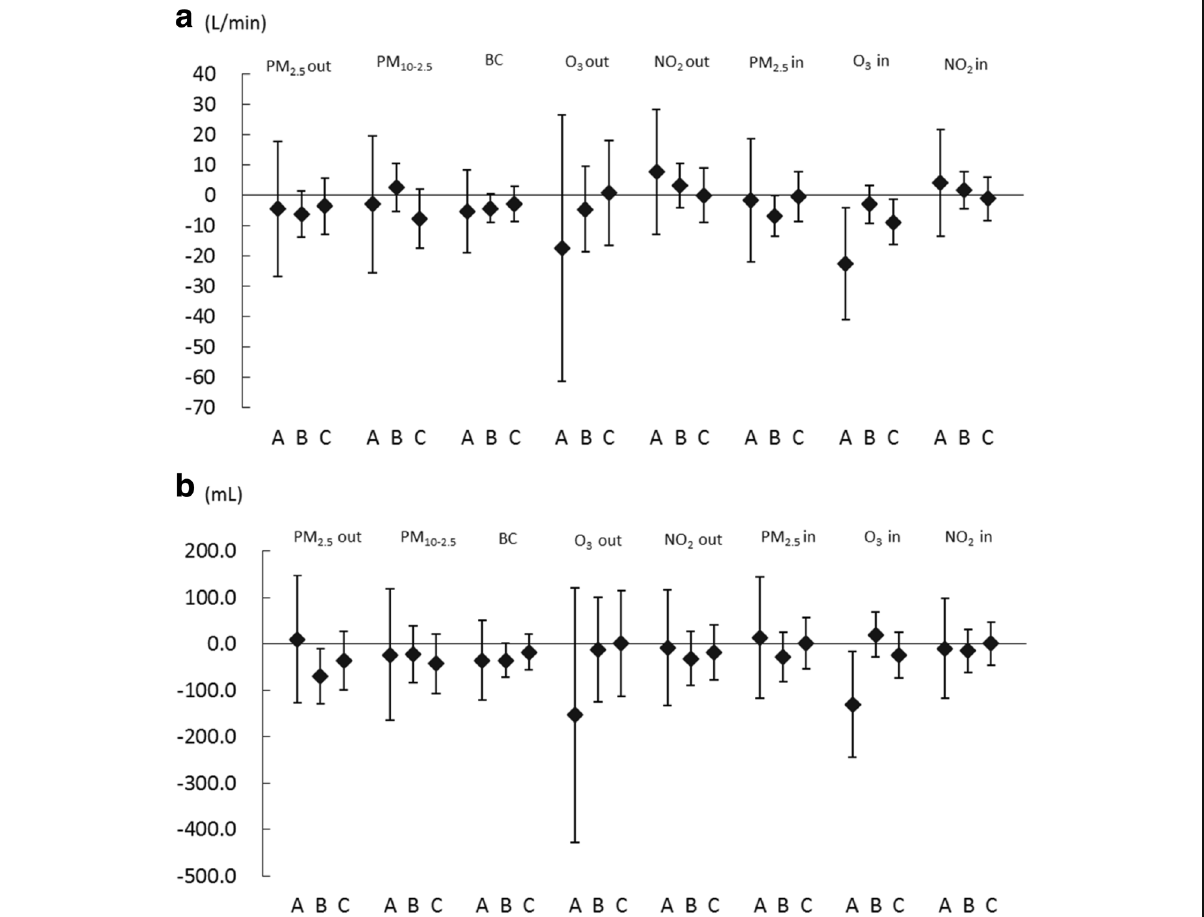
Fig. 3 Estimated changes in ( a ) PEF and ( b ) FEV 1 with increases in air pollutants in relation to a history of asthma or allergy. The estimated changes and 95% confidence intervals for ( a ) PEF and ( b ) FEV 1 are shown per increase in interquartile range (IQR) of the concentration of air pollutants in relation to a history of asthma or allergy. A: Subjects with a history of asthma. B: Subjects with a history of allergy other than asthma. C: Subjects without a history of asthma or